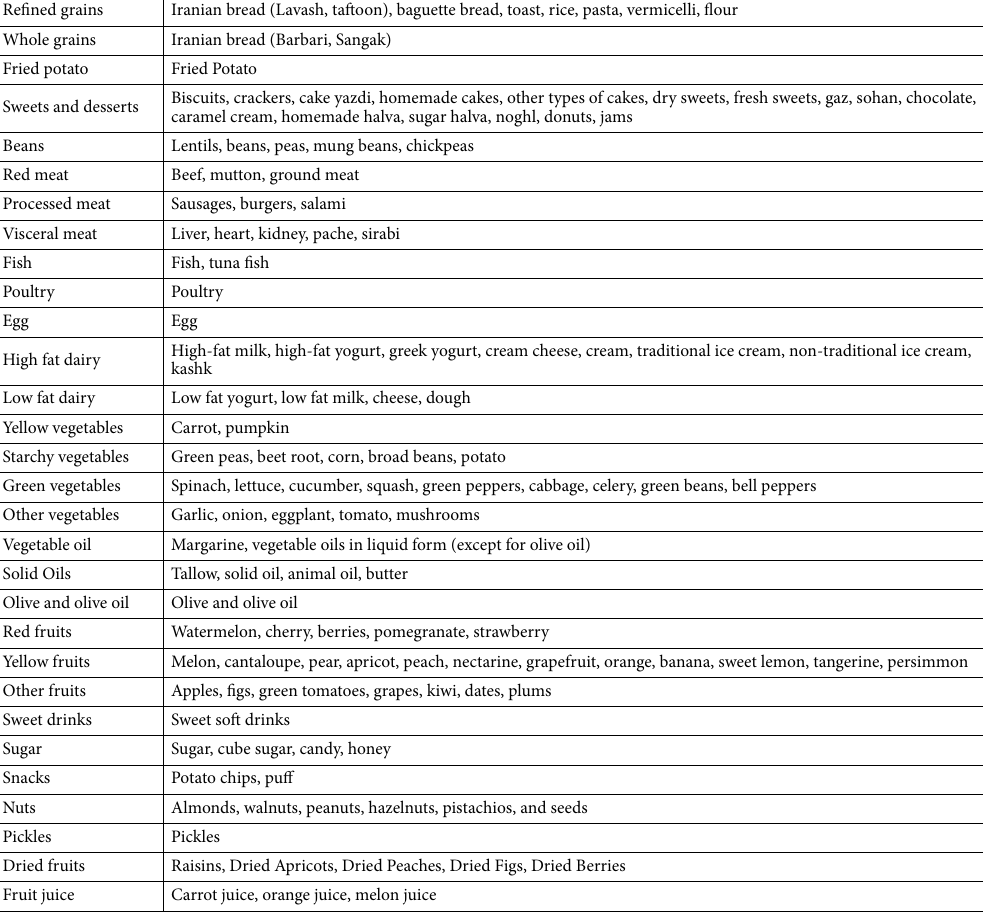
Table 1. Food groups and food items of FFQ used in the